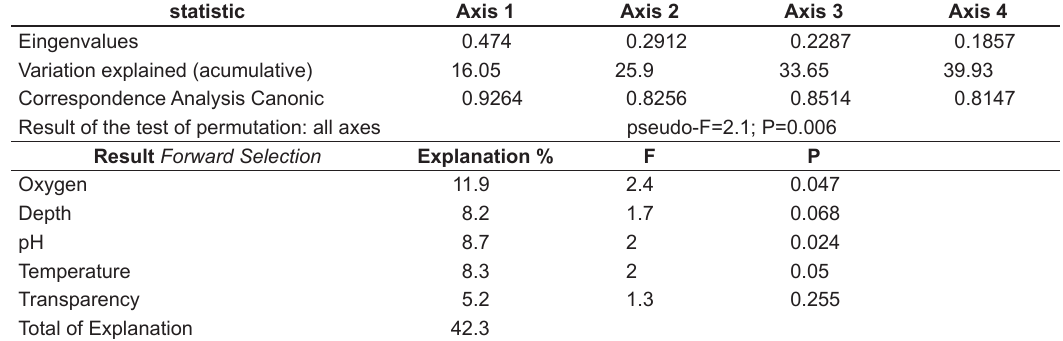
Table 3. Results of the statistical analysis of the eigenvalues, percentages of the variance explained by the relation Proxy of the landscape and limnological signature of the significant axes of the Correspondence Analysis Canonic in the reservoir of the UHE of Curuá-Una, in the month of November,